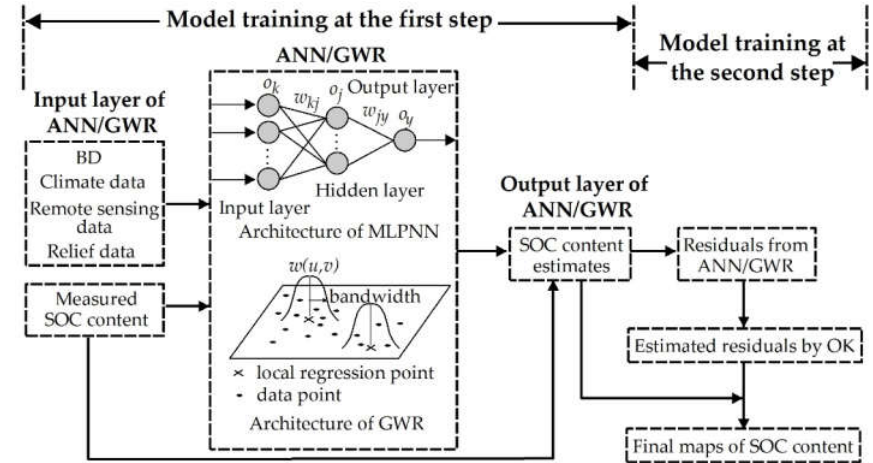
Figure 3. Flow diagram of soil organic carbon (SOC) content mapping using two-step hybrid approaches of geographically weighted regression kriging (GWRK) and artificial neural networks kriging (ANNK).